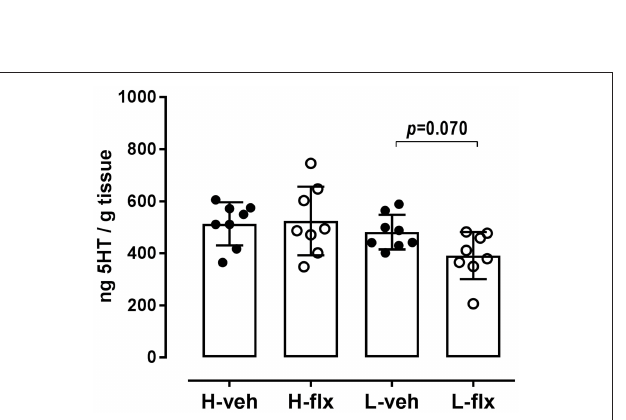
FIGURE 6 | 5HT content in the frontal cortex tissue. Cortical tissue was collected 48h after the 27th injection of vehicle or fluoxetine. Data from individual animals are shown and group means ± SD are indicated, n = 8 per group [ F 3, 28 = 3.173, p = 0.0396, 1w-ANOVA; p -value obtained by Fisher’s LSD post-hoc test is given]. H, high-5HT animals; L, low-5HT animals; veh, vehicle; flx,